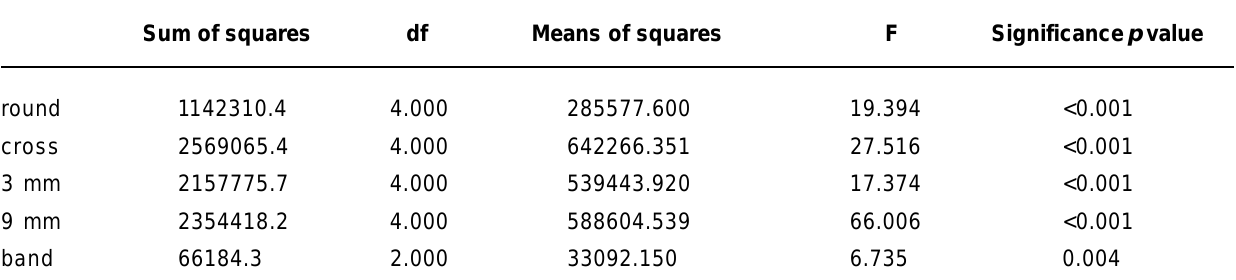
TABLE 5- Results of A NOVA (p=level of significance)